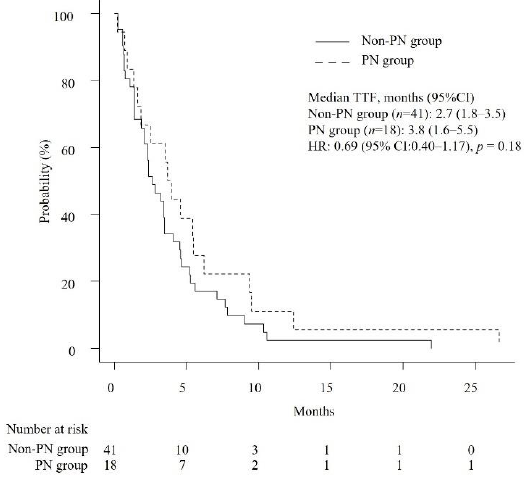
Figure 3. Kaplan – Meier curves comparing the time-to-treatment failure of patients with unresec- Figure 3. Kaplan–Meier curves comparing the time-to-treatment failure of patients with unresectable table APC who received second-line GnP. PN : peripheral neuropathy, TTF : time-to-treatment fail- ure, HR : hazard ratio.